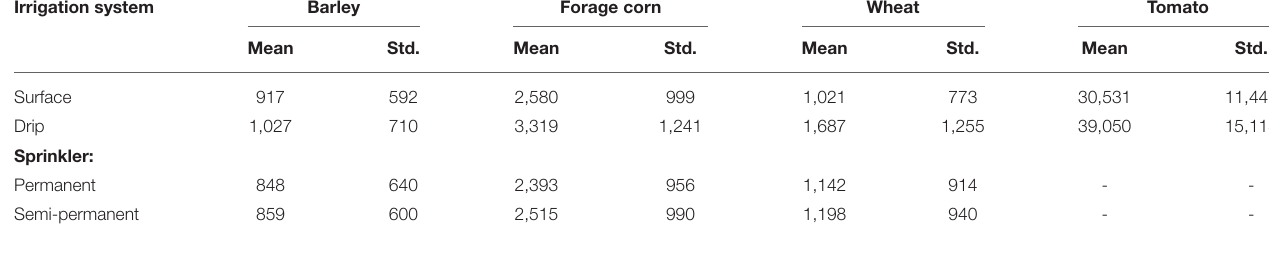
TABLE 3 | Summary statistics of simulated net returns by irrigation systems (10,000 Rials/ha). Irrigation system Barley Forage corn Wheat